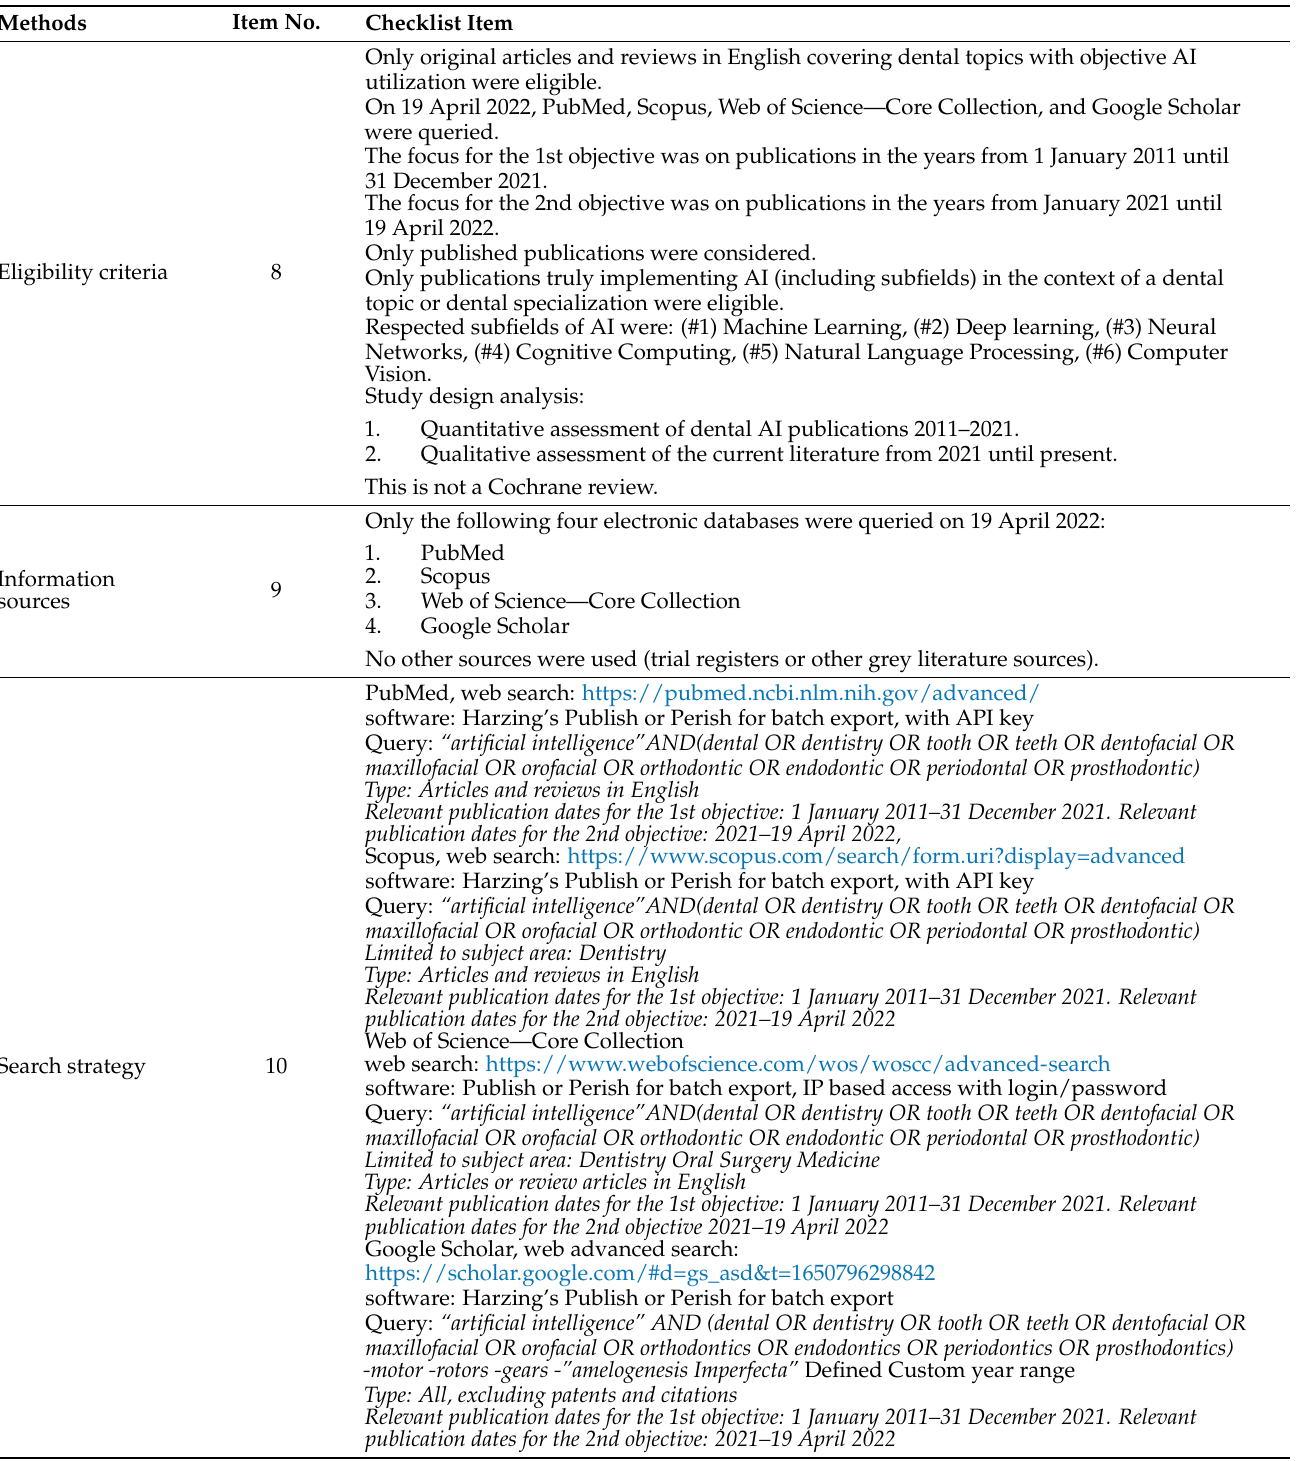
Table 1. Review protocol, compliant with PRISMA-P (Preferred Reporting Items for Systematic review Protocols 1